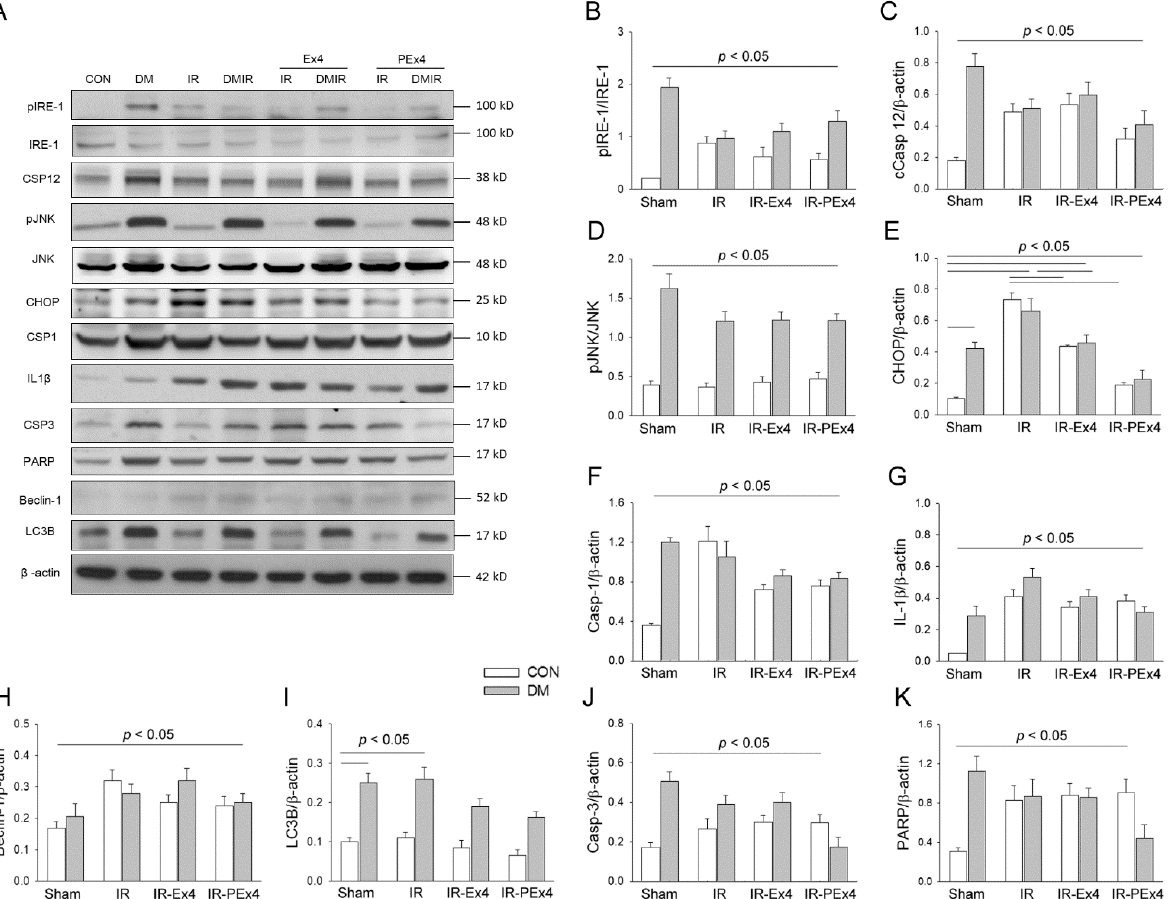
Figure 9. The effect of Ex-4 and PEx-4 treatment on ER stress-, apoptosis-, pyroptosis- and autophagy-associated proteins in Con or DM rat bladders with or without IR injury ( A ). The levels of ER stress-associated proteins including pIRE-1/IRE-1 ratio ( B ), cleaved Caspase-12 ( C ), pJNK/JNK ratio ( D ), CHOP ( E ), pyroptosis-related proteins including, Caspase-1 ( F ), IL-1β ( G ), autophagy-associated protein Beclin-1 ( H ), LC3B ( I ), and apoptosis-associated proteins including cleaved Caspase-3 ( J ) and PARP ( K ) are up-regulated in DM as compared to Con. IR enhanced pIRE-1/IRE-1, Caspase 12, CHOP, Caspase-1, IL-1β, Beclin-1, LC3B, Caspase 3 and PARP in ConIR as compared to Con. Ex-4 or PEx-4 treatment only efficiently down-regulated CHOP expression in the Con and DM rats of IR-Ex4 and IR-PEx4 groups. Data are expressed as mean ± SEM in each group ( n = 6) using the single values. The statistical difference is indicated by the horizontal line with p < 0.05 between groups using one-way ANOVA, followed by Bonferroni’s post hoc test.